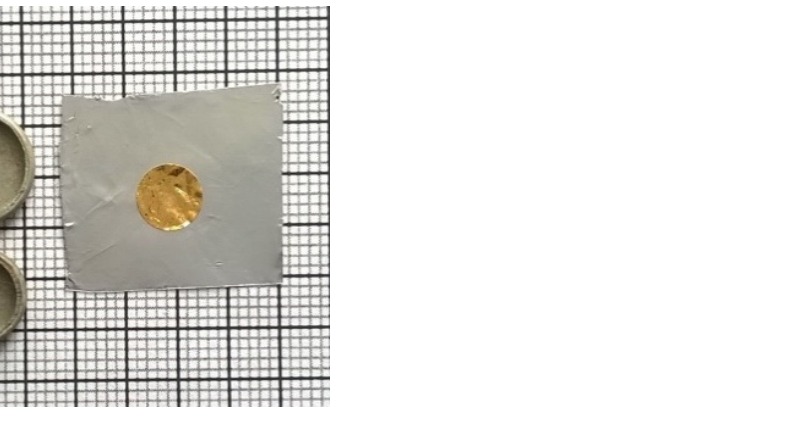
Figure 10 . Gold detector and cadmium cover used for epithermal neutron fluence rate measure- Figure 10. Gold detector and cadmium cover used for epithermal neutron fluence rate ments .